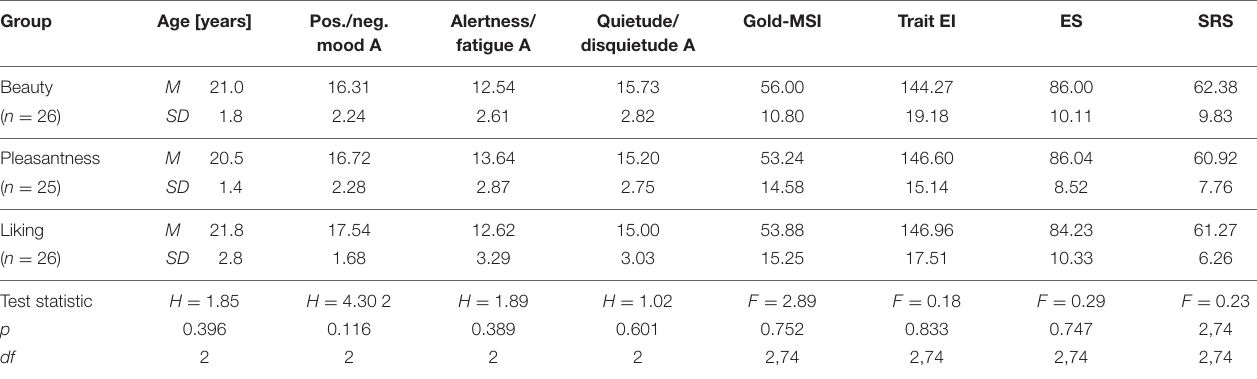
TABLE 6 | Participant characteristics.